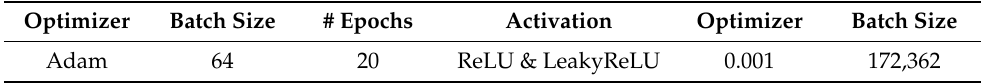
Table 3. Broad summary of the model. Optimizer Batch Size # Epochs Activation Optimizer Batch Size Adam 64 20 ReLU & LeakyReLU 0.001 172,362